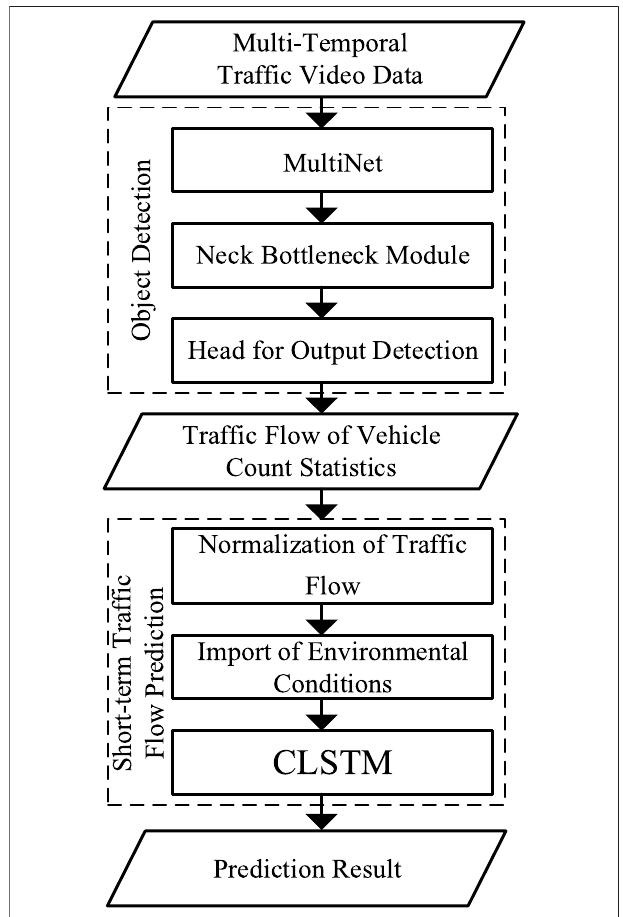
FIGURE.1 | Structure of the proposed